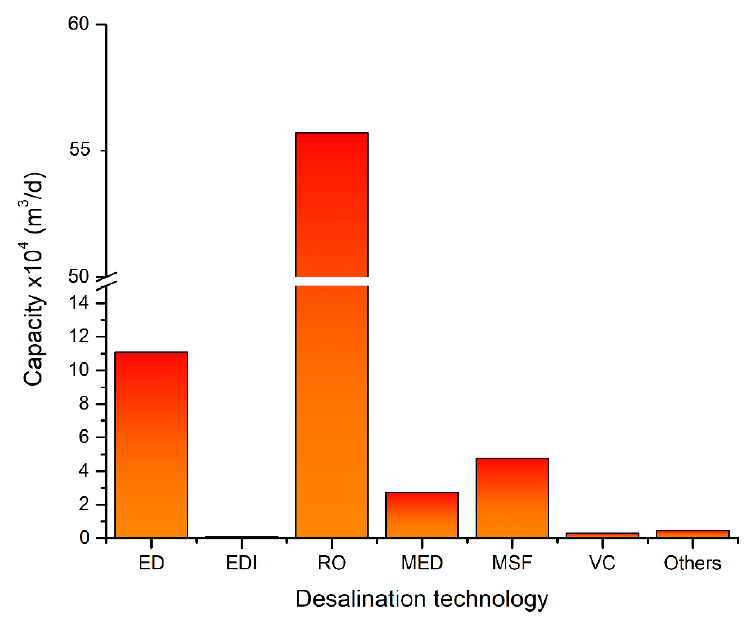
Figure 5. Installed capacity per type of desalination technology in Mexico in 2022 [8].